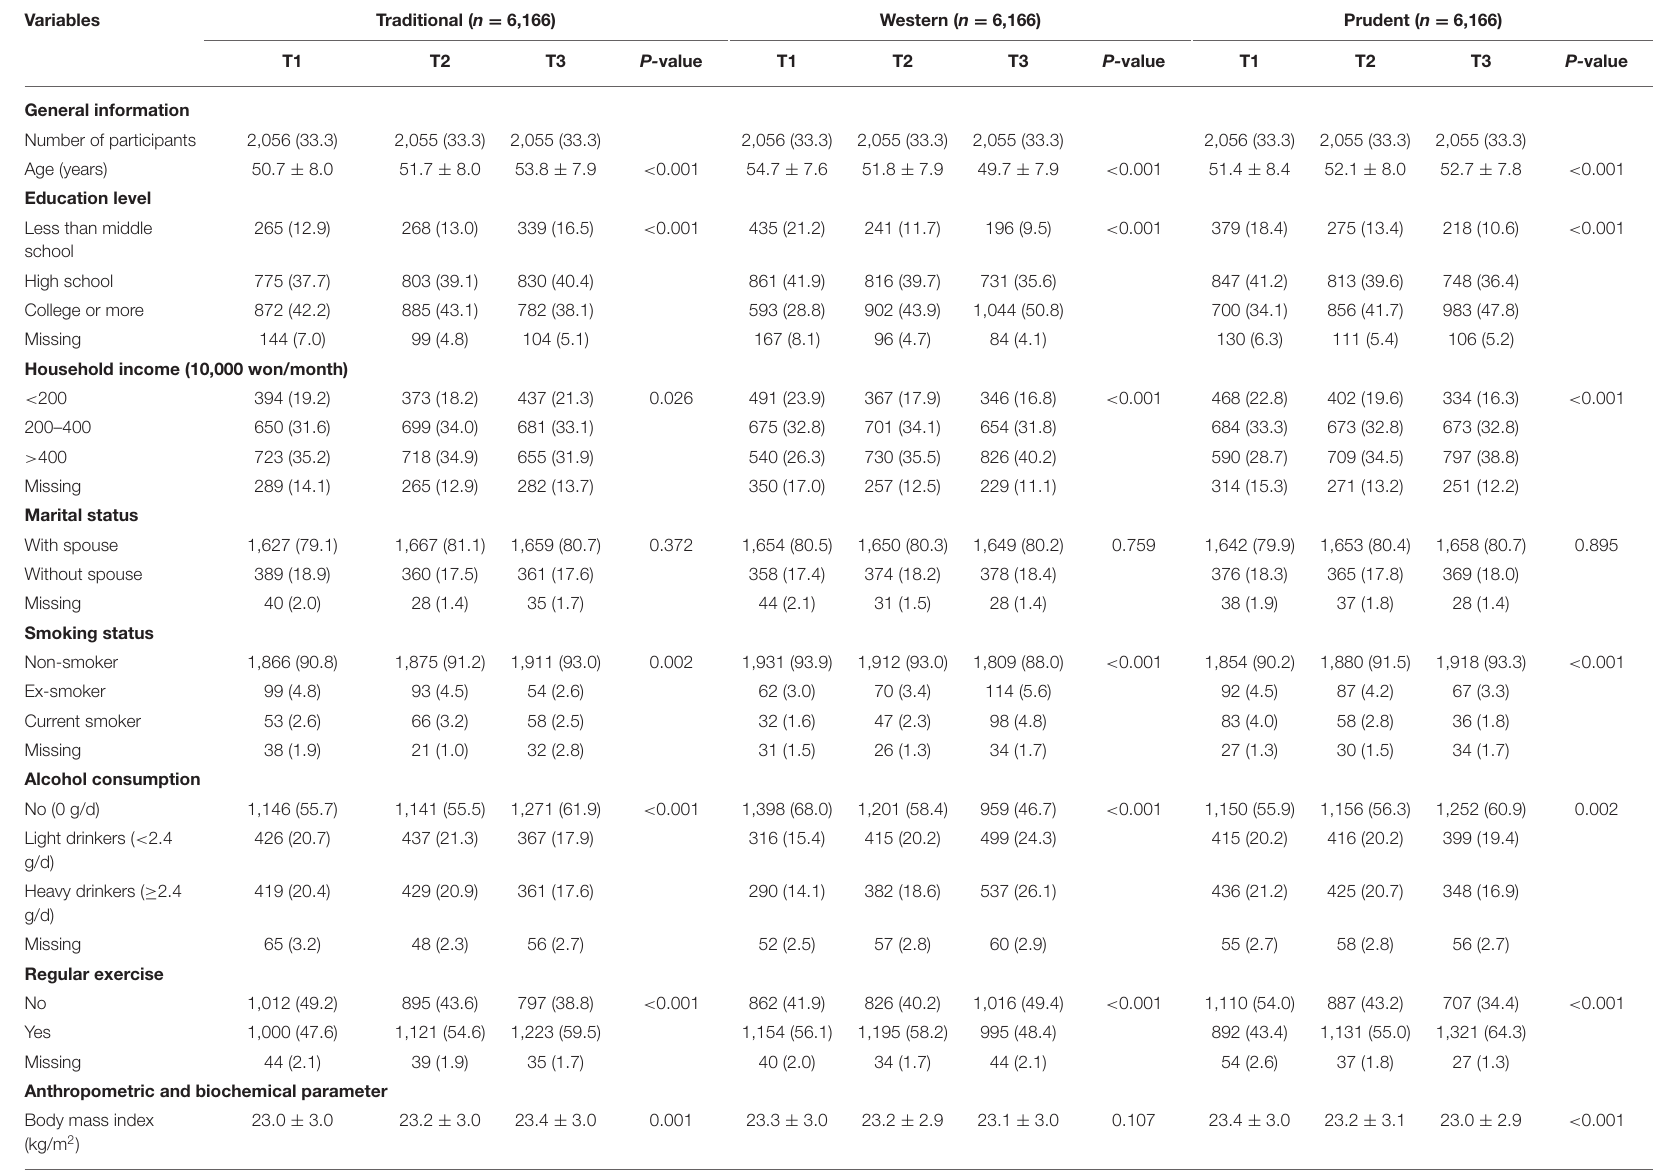
TABLE 4 | General characteristics by tertiles of dietary pattern score